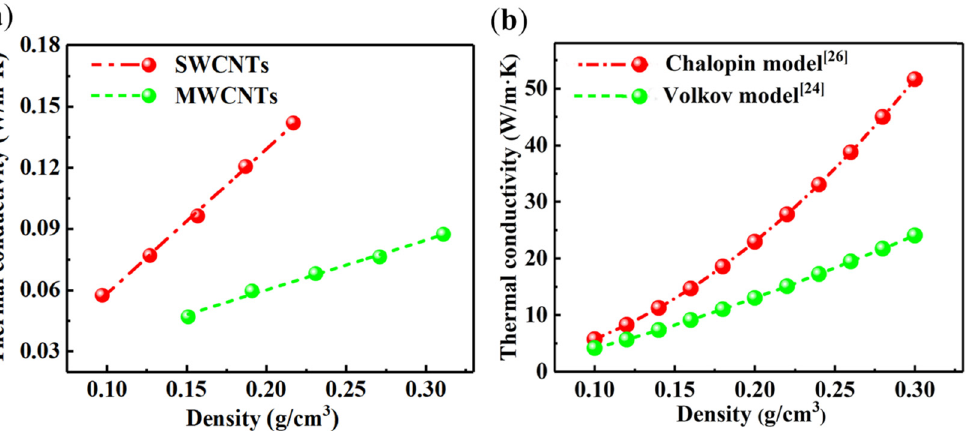
Figure 3: Thermal conductivity of the SWCNT and MWCNT packed bed as a function of density: ( a ) experimental results; ( b ) calculation results by Chalopin ’ s model [ 24 ] and Volkov ’ s model [ 26 ]